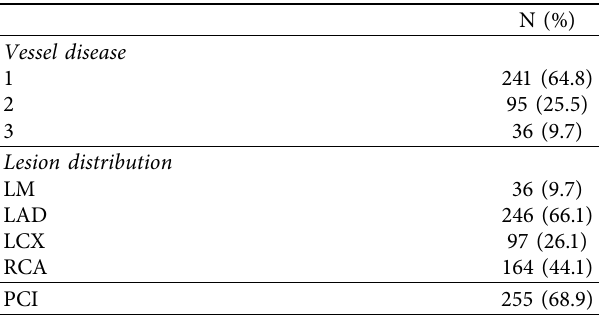
Table 3: Angiographic characteristics of CAD-TAVI group ( N �